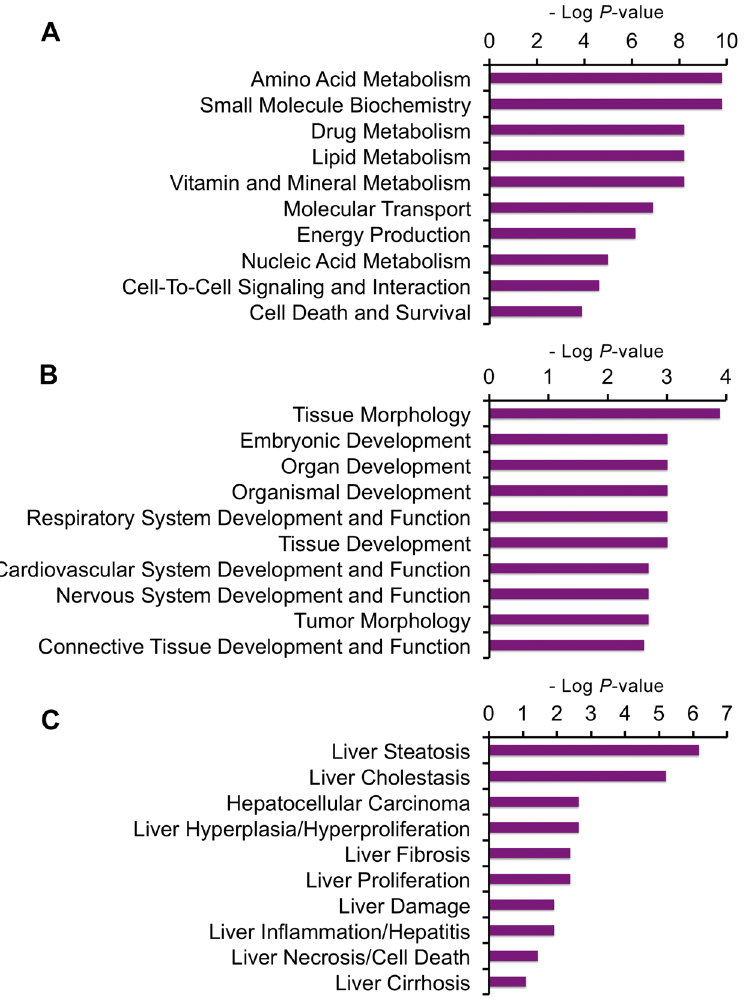
Figure 3. Functional characterization of the differentially expressed proteins in -Leu/Ctrl. ( A ) Molecular and cellular functions. ( B ) Physiological system development and functions. ( C ) Hepatotoxicity. More information is available in Supplementary Table